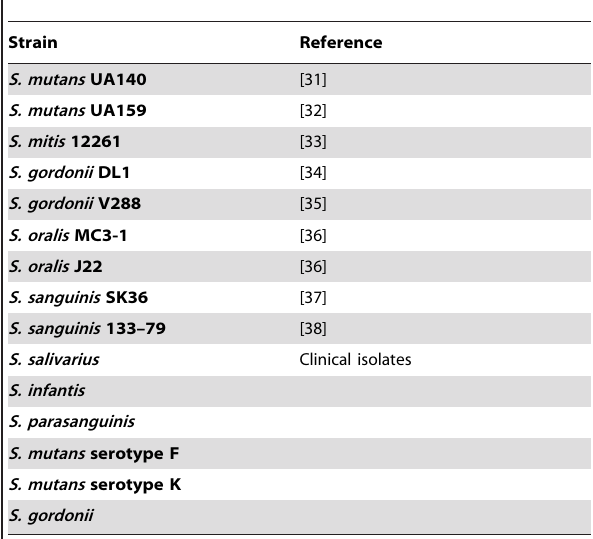
Table 1. Bacterial